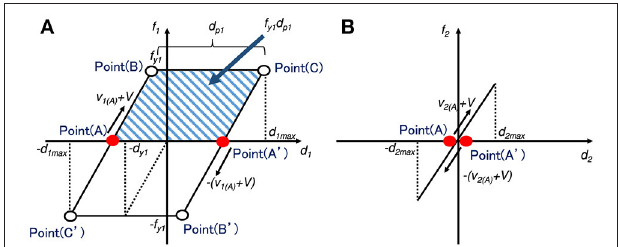
FIGURE 3 | First- and second-story restoring force-interstory drift relations for evaluating the maximum deformation, (A) Restoring force-interstory drift relation in first story, (B) Restoring force-interstory drift relation in second story.